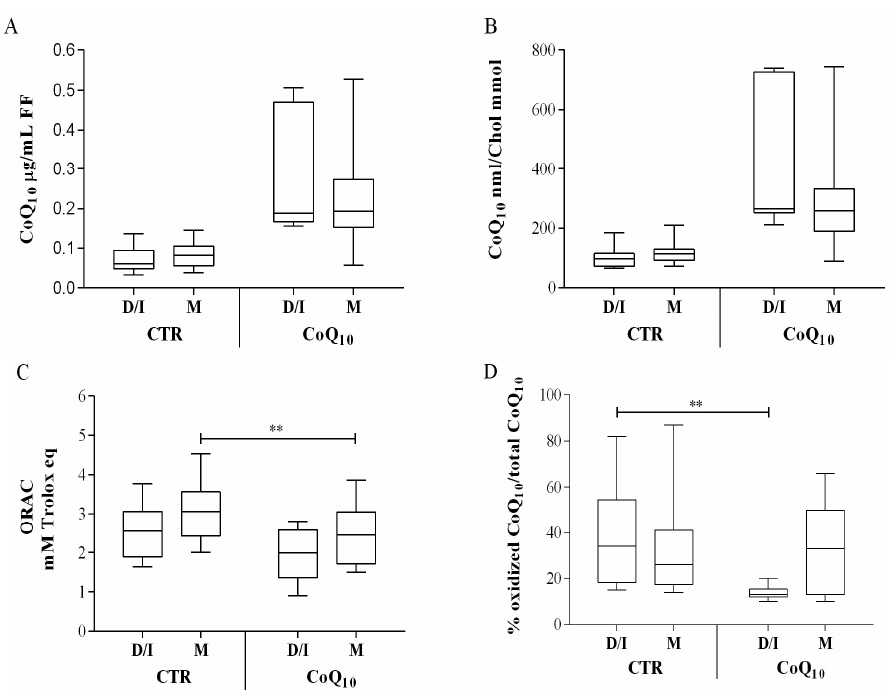
Figure 3. Oocyte-containing follicles coenzyme Q10 content and oxidative parameter in control (CTR) and supplemented IVF patients (Q10) in relation to follicle maturation stage. CoQ10 is expressed both per volume of follicular fluid as µ g CoQ10/mL FF ( A ) or normalized for cholesterol content as nmol CoQ10/mmol Chol ( B ); ORAC value is expressed as mMTrolox equivalents ( C ) while CoQ10 oxidation is expressed as % of oxidized CoQ10/total CoQ10 ( D ). ** p < 0.01.